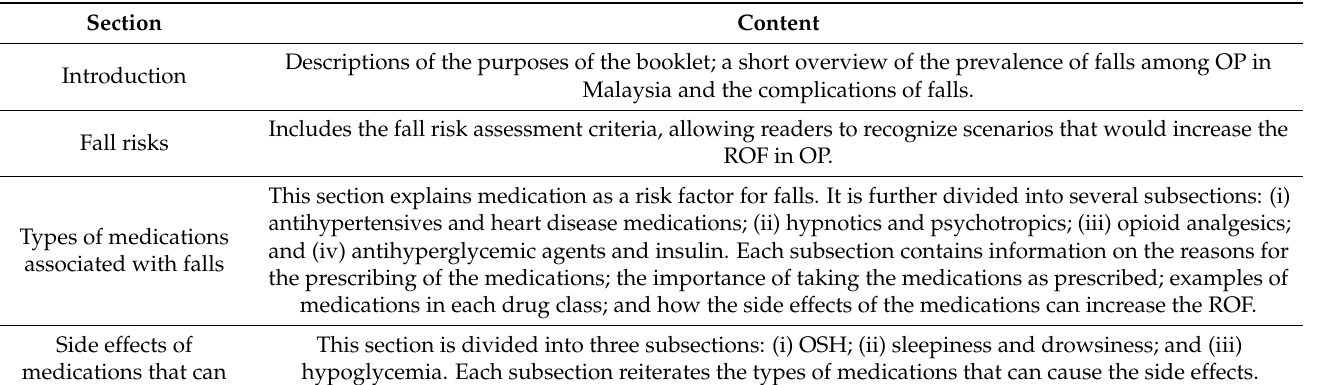
Table 1. Content of the draft